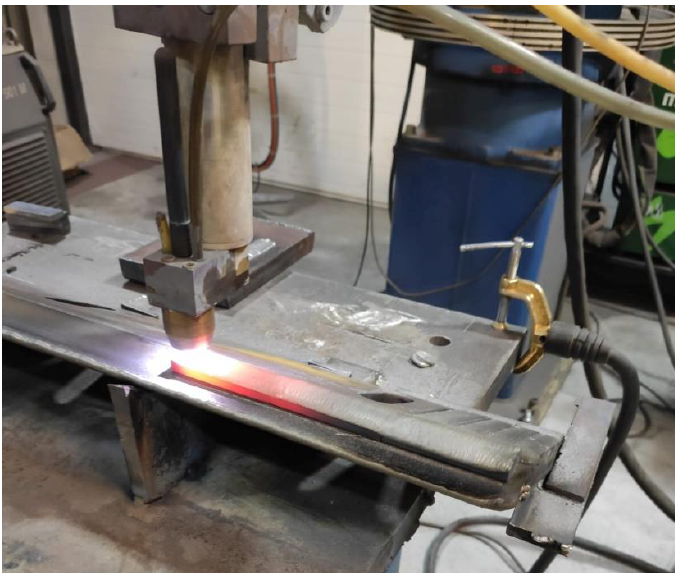
Figure 2. View of the powder plasma transferred arc welding (PPTAW) processes.